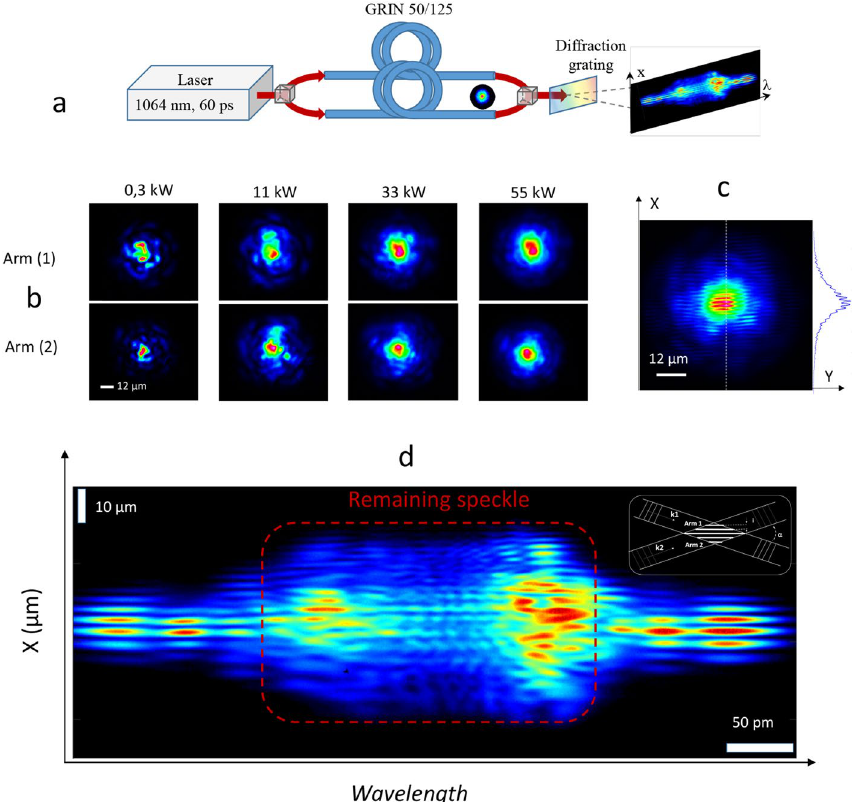
Figure 1. Experimental evidence of phase locking between two self-cleaned beams in GRIN MMFs. ( a ) Schematic representation of the experimental setup as detailed in the Methods section. ( b ) Near-field images of the output beams observed for increasing input peak power, independently recorded in the two arms of the Mach–Zehnder interferometer, seeded by the same laser source at 1064 nm. ( c ) Spatial interference pattern produced by the two self-cleaned output beams, spatially superimposed with a 4° tilt angle (44 kW). ( d ) Same interference pattern between the two self-cleaned output beams (obtained for 44 kW input power), but spectrally decomposed along wavelength. Note that here, the vertical axis corresponds to the X transverse